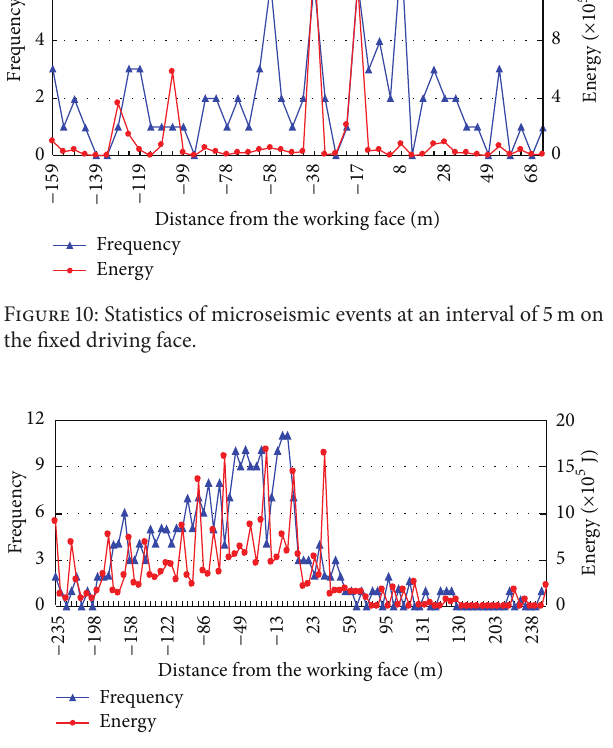
Figure 11: Statistics of microseismic events at an interval of 5 m on the fixed stopping